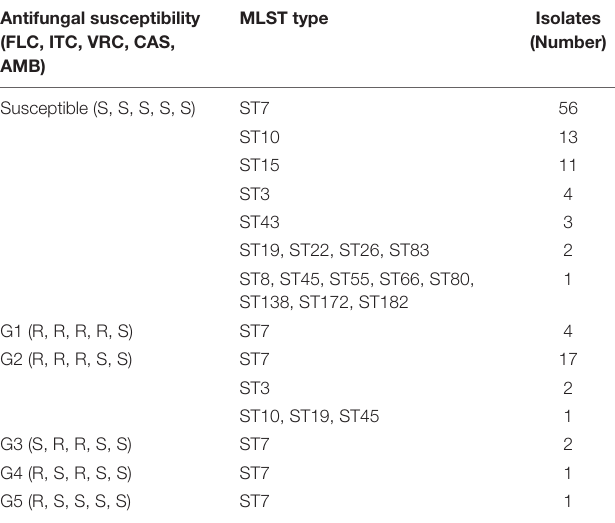
TABLE 4 | Multilocus sequence typing (MLST) genotype and antifungal susceptibility clusters. Antifungal susceptibility (FLC, ITC, VRC,